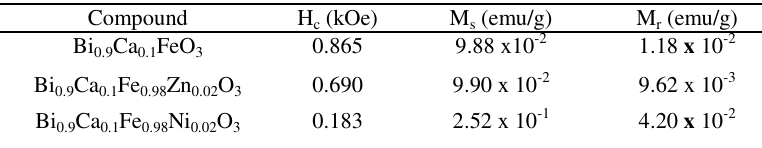
Table 3. Some magnetic parameters of the Ca-doped BiFeO